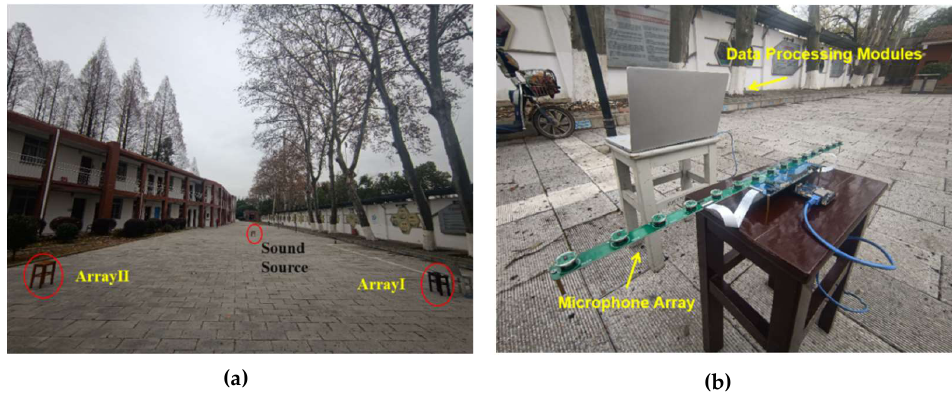
Figure 7. (a) Experimental scene. (b) Experimental equipment. Figure 7. ( a ) Experimental scene. ( b ) Experimental equipment.